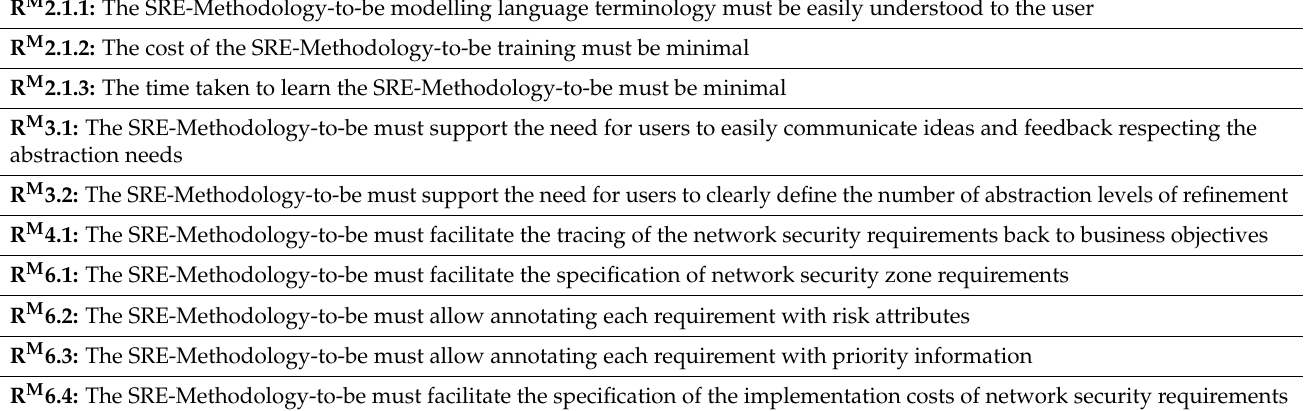
Table 4. Elicited evaluation criteria